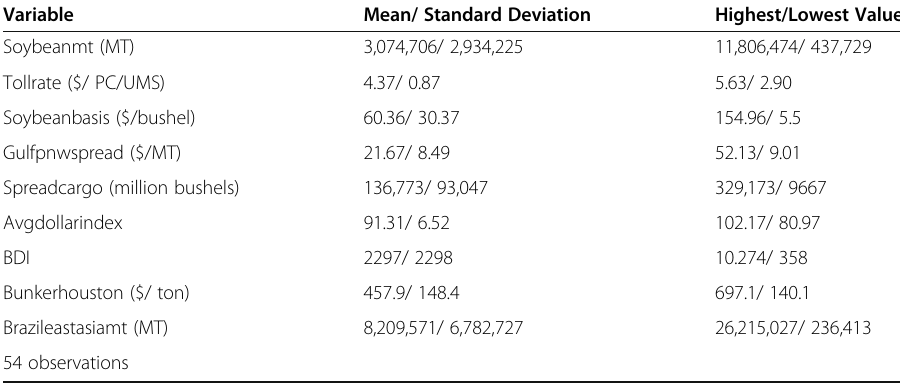
Table 3 Descriptive statistics for quarterly- transformed data Variable Mean/ Standard Deviation Soybeanmt